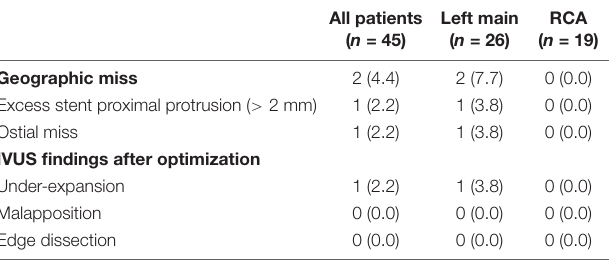
TABLE 4 | Clinical outcomes at 6-month follow-up. Clinical outcome